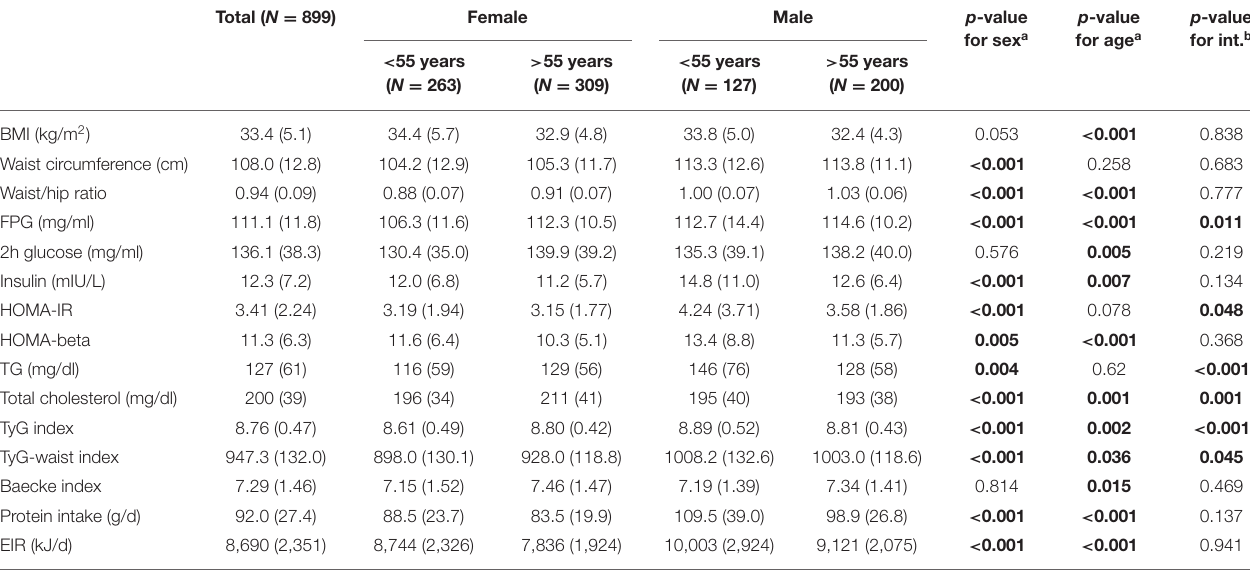
P-values show significant differences and interactions. a ANOVA analysis.